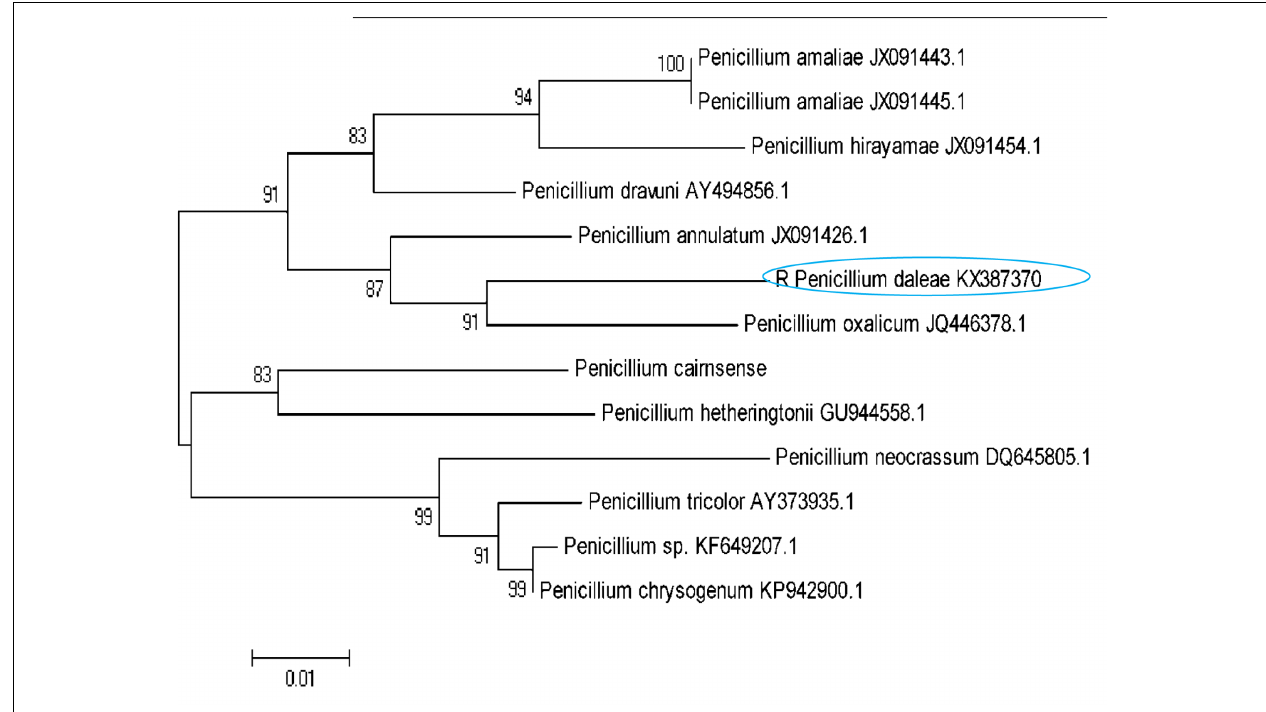
FIGURE 2 | A neighbor-joining tree of the Penicillium species relative to the P. daleae isolate based on phylogenetic analysis of the nuclear ribosomal ITS1-5.8S-ITS2 region sequences. Bootstrap values of 1000 analyses are shown at the branching point. The type strain of the species and accession numbers are indicated as “T” and in parentheses, respectively (Tamura et al.,